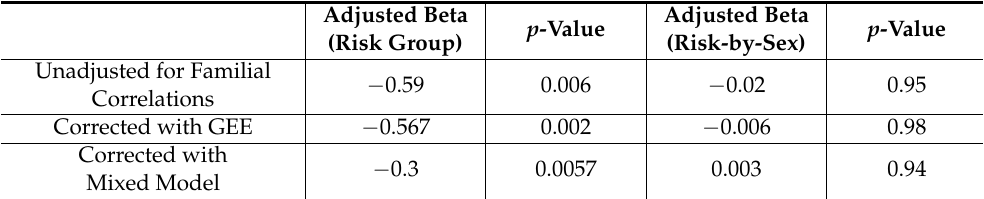
Figure 3. Maps of the Main Effect of Parental Depression on Surface Morphological Features of the Hippocampus and Amygdala. Groups were redefined as either having at least one parent with a lifetime history of depression (N = 94) or having no parent with a lifetime history (N = 54). Using this alternative definition, we reassigned group status for 19 of the 67 LR participants and 6 of the 81 HR participants. Findings were similar to those comparing high- vs. low-risk (Figure 2). Table 3. Adjusting for the Non-Independence of Data on Group Differences.